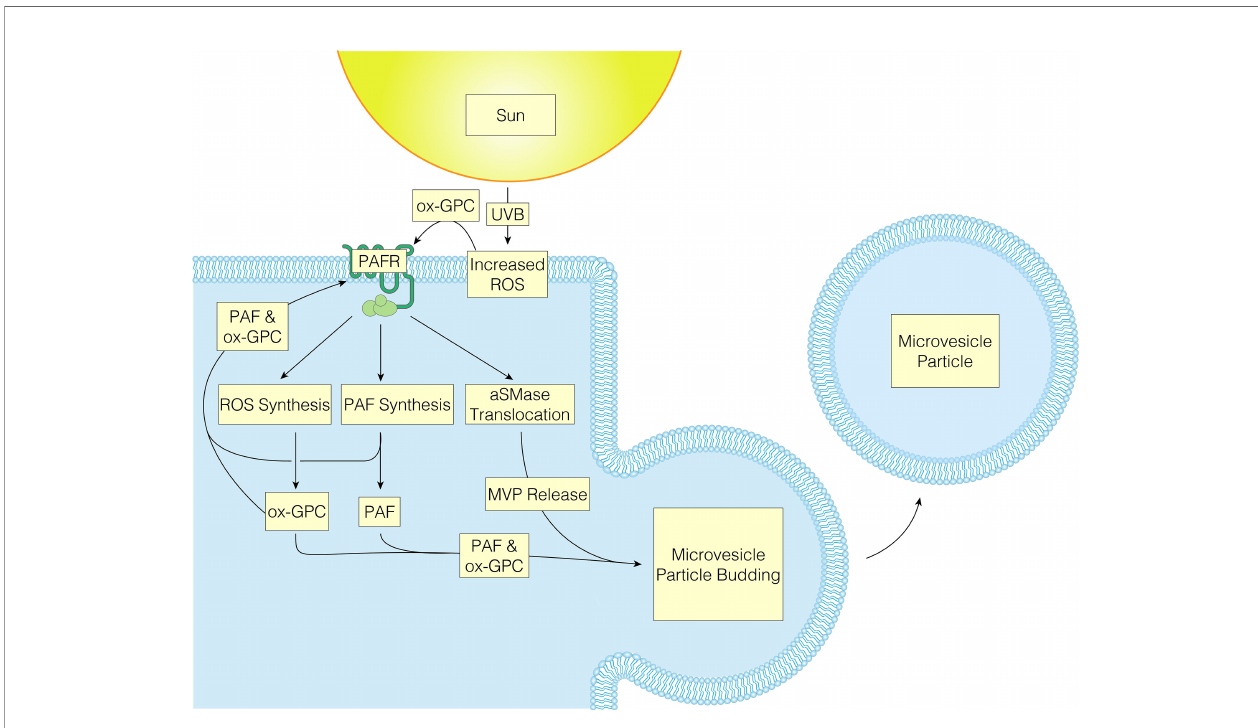
FIGURE 1 | PAF biosynthesis